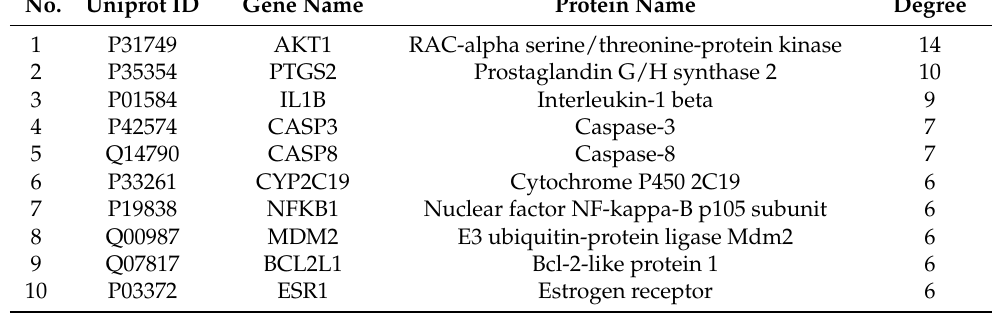
8 of 19 Figure 3. Compound–disease–target network. The purple hexagon represents AR. The yellow tri- angle represents the active compound contained in AR. The red diamond represents GU. The green ellipse represents the targets. 3.4. PPI Network Construction and Hub Targets The common targets of AR and GU were uploaded to the STRING database, and the PPI network was visualized through Cytoscape 3.8.0 software. There were 31 nodes (six free nodes were hidden) and 66 edges in the network. The top 10 key targets were